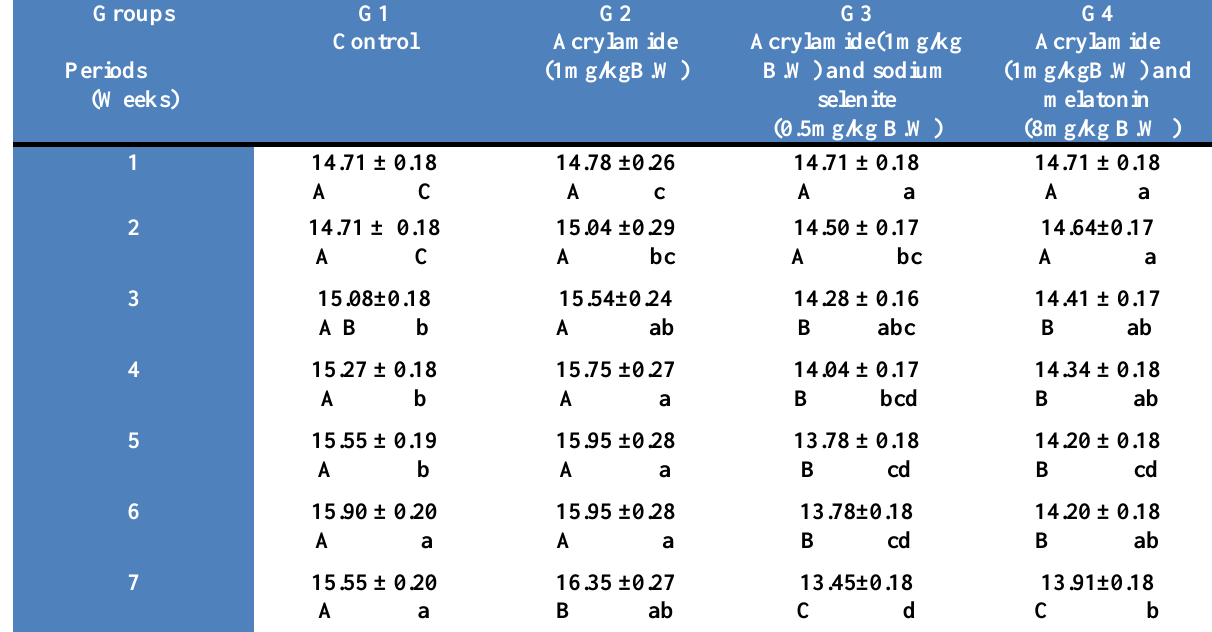
Table, 1: Effect of sodium selenite and melatonin on waist circumference (cm) in acryl amide treated rats. Groups Periods (Weeks)